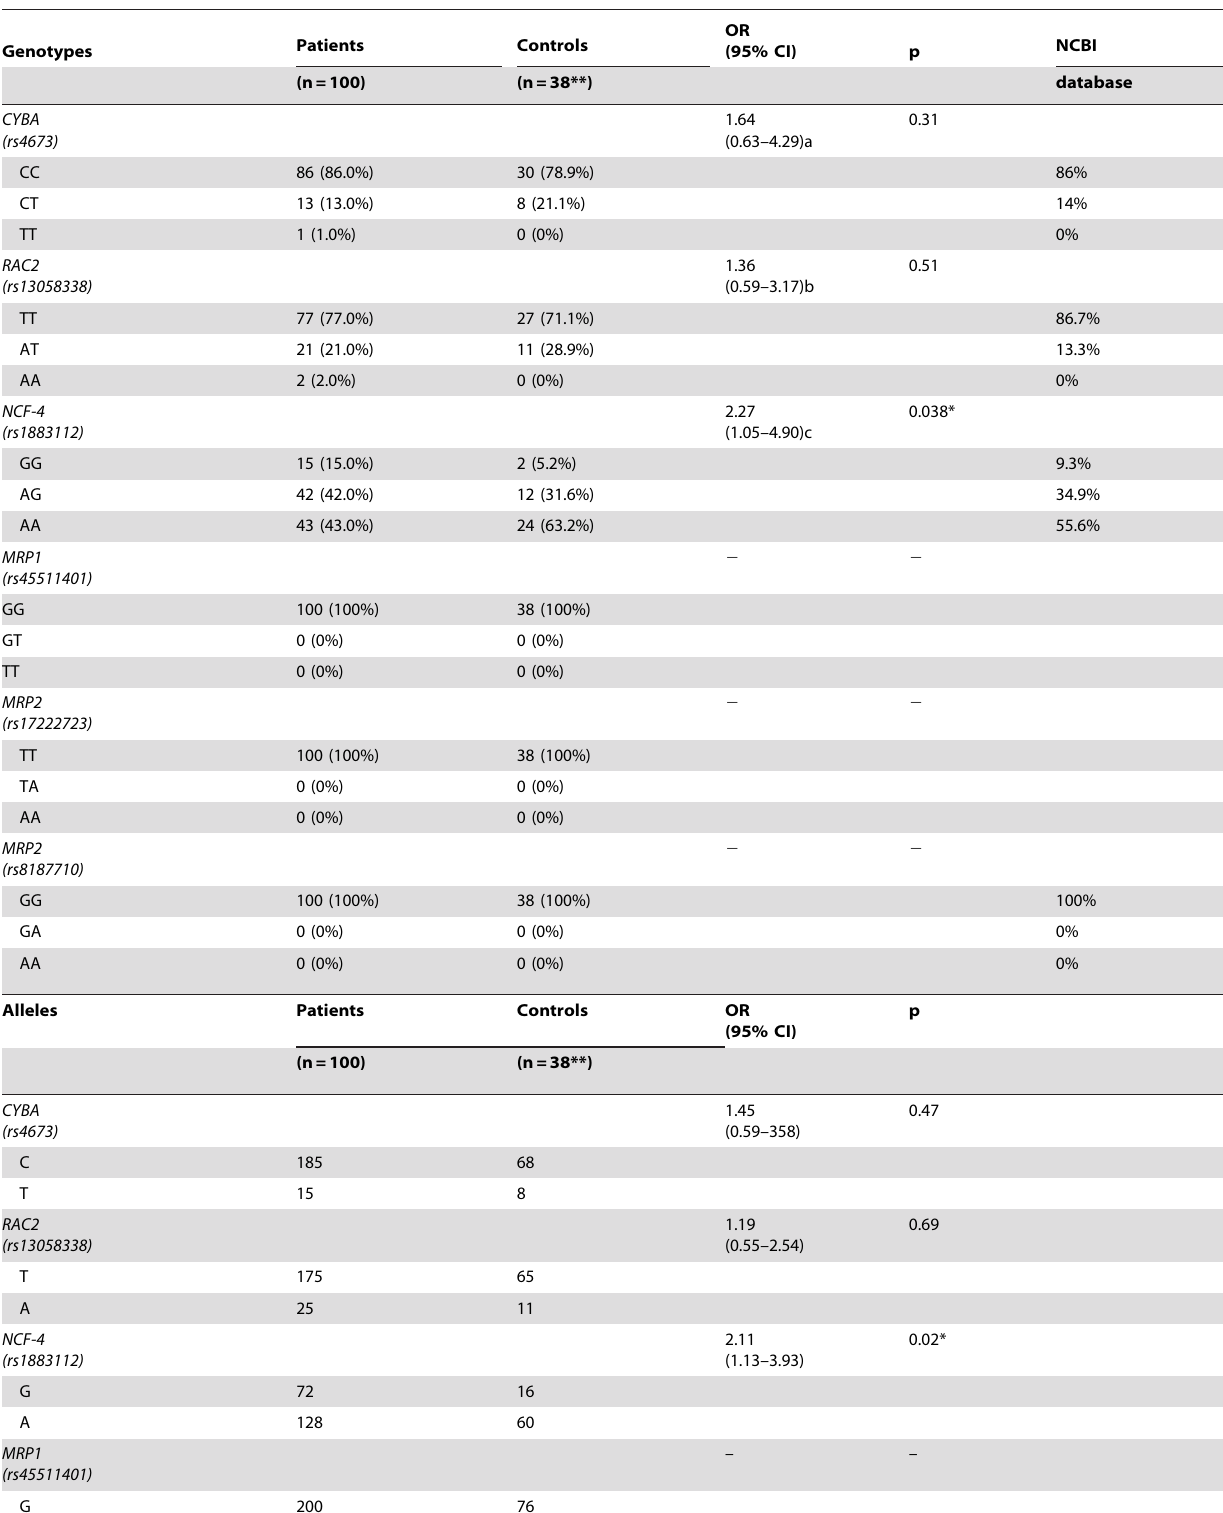
Table 3. Genotypic and allelic frequencies of NAD(P)H oxidase and multidrug resistance protein genes in survivors and control subjects, and genotypic frequencies reported in Chinese population from National Center for Biotechnology Information (NCBI)